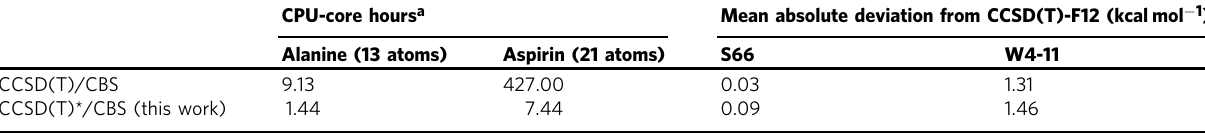
Table 3 Computational cost and accuracy of our coupled-cluster